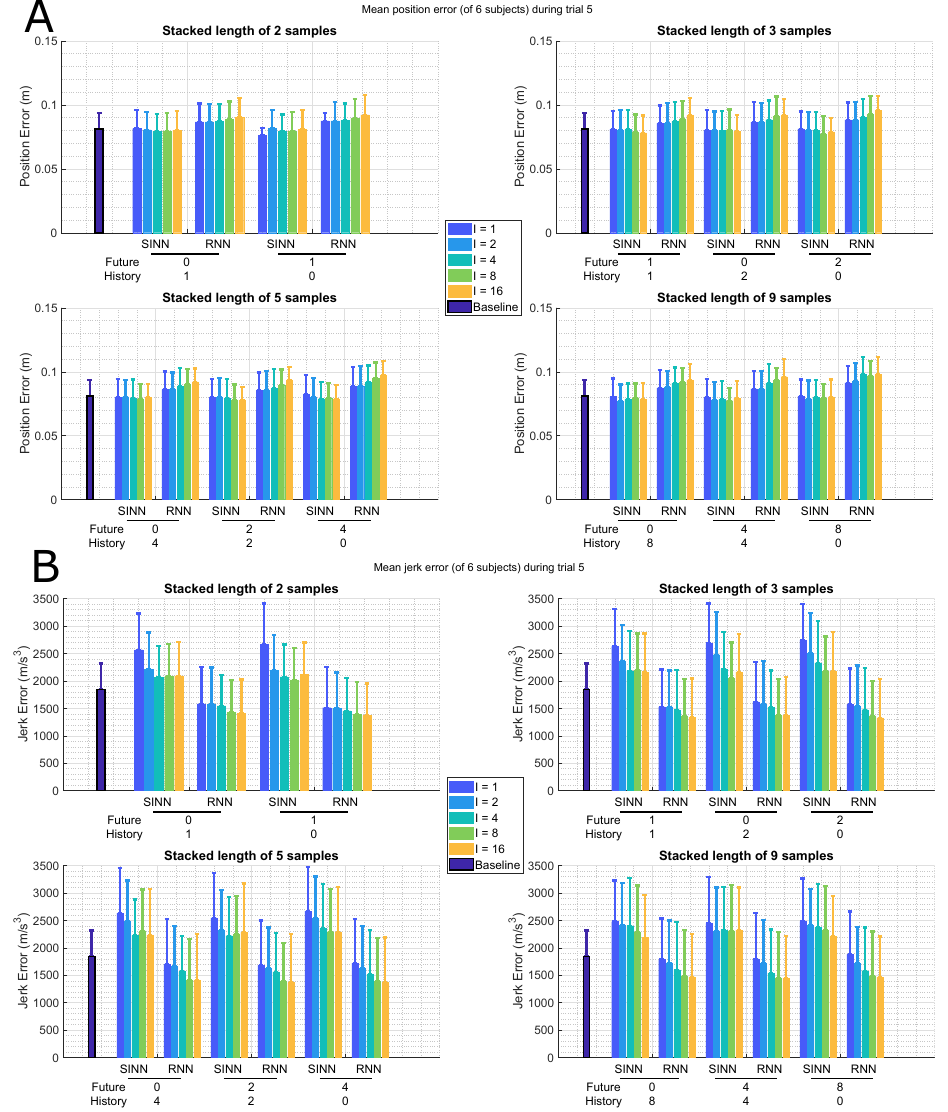
Figure 5. Bar plots of the full-body mean (of 6 subjects) joint position ( A ) and jerk ( B ) error for the shallow (SINN, left bars for each configuration ) and deep (RNN, right bars for each configuration ) learning approaches during an ADL trial (5 in Table 1), standard deviation over the various subjects is displayed by whiskers. The different time windows are presented on the x -axis, where the number of past ( P ) and future ( F ) poses are shown. The interval ( I ) between input poses are marked by the different colours, where the number of samples between input poses is shown. For comparison, the mean joint position error ( A ) for using only the current pose as input (SINN approach) is 0.08 ( ± 0.01) m. For comparison, the mean joint jerk error ( B ) for using only the current pose as input (SINN approach) is 1.8 ( ± 0.5) × 10 3 m/s 3